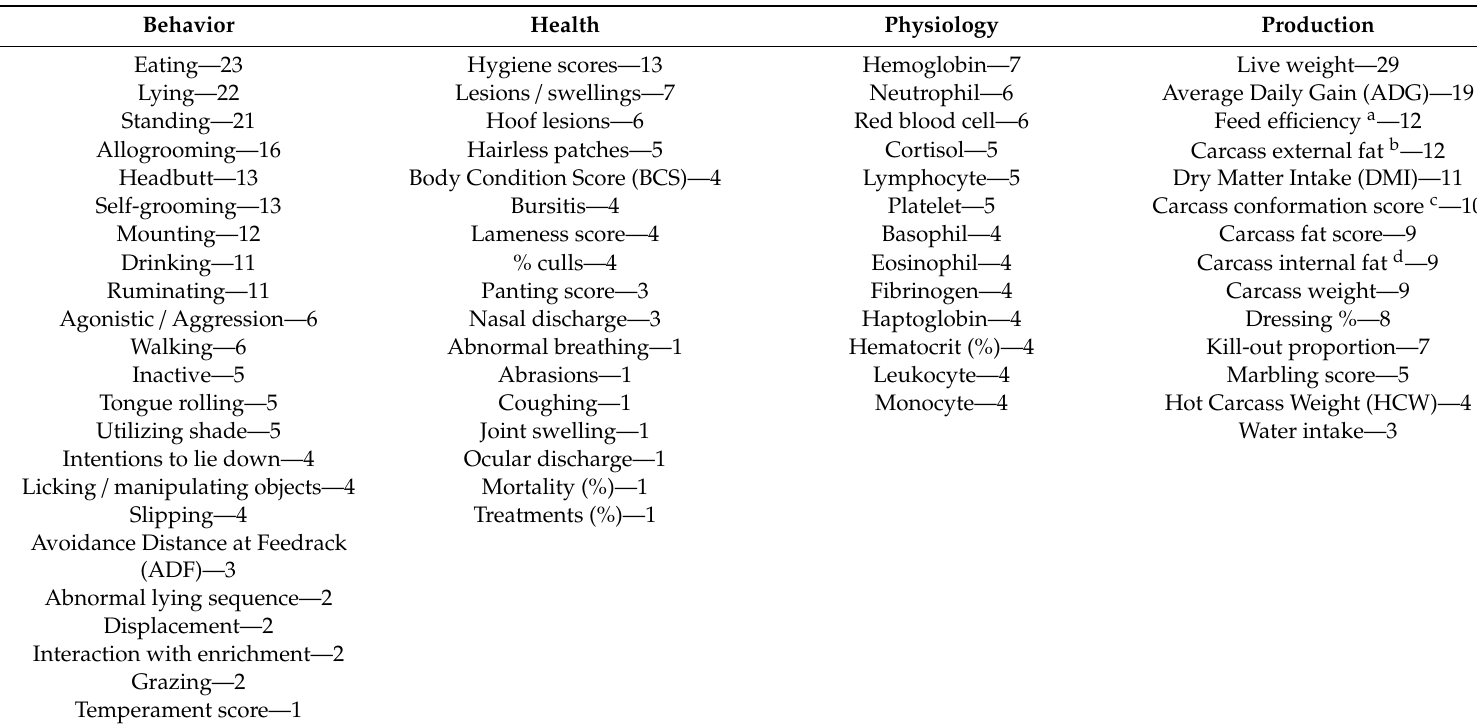
Table 2. Author-selected behavioral, health, physiological, and production measures that were extracted from the included beef cattle housing studies. The number beside each measure indicates how many studies in this scoping review reported that specific